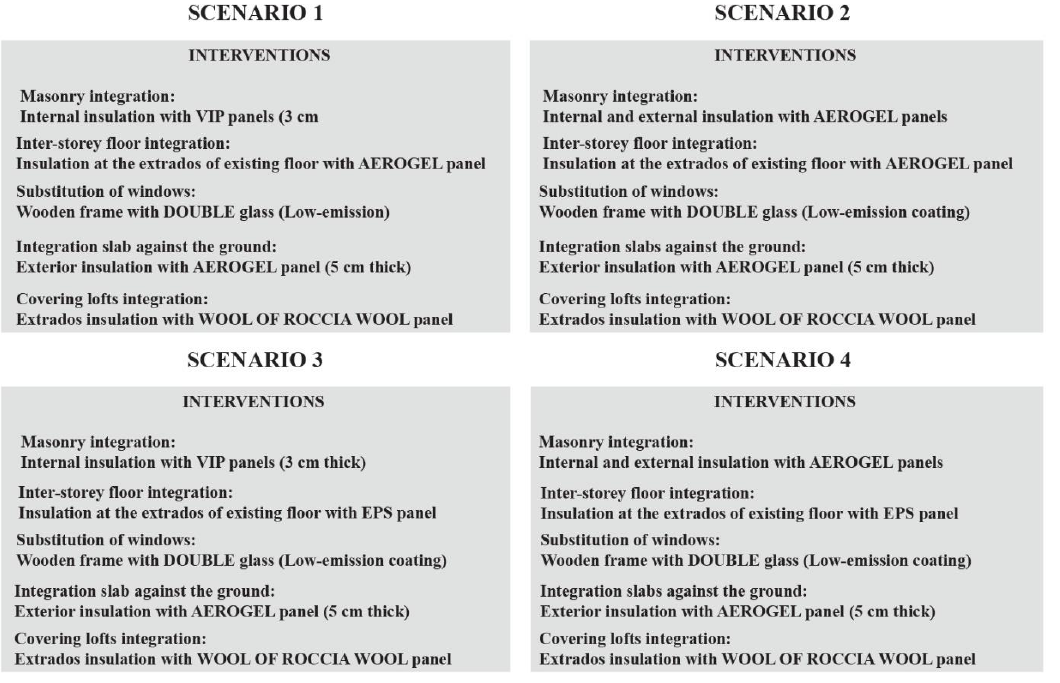
Figure 17. Four scenarios with a combination of the different interventions.